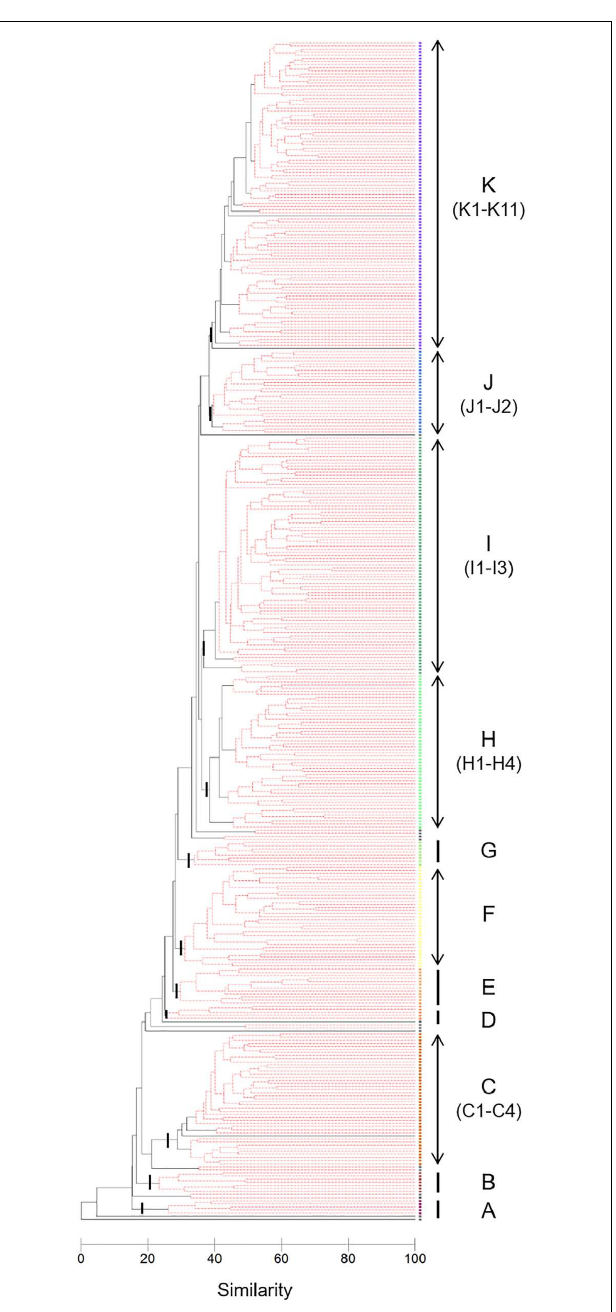
FIGURE 3 | Dendrogram based on fourth-root transformation, Bray–Curtis similarity, and group-average clustering. The SIMPROF test identified 11 main clusters (A–K) with a total of 40 significant sub-divided groups (black branches, p <